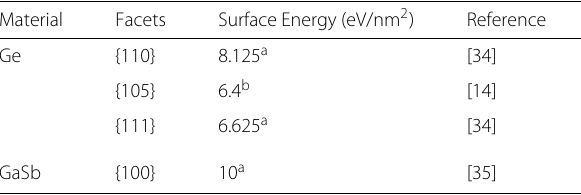
Table 1 The average surface energy of different facets in Ge and GaSb at 300 K Material Facets Surface Energy (eV/nm 2 )